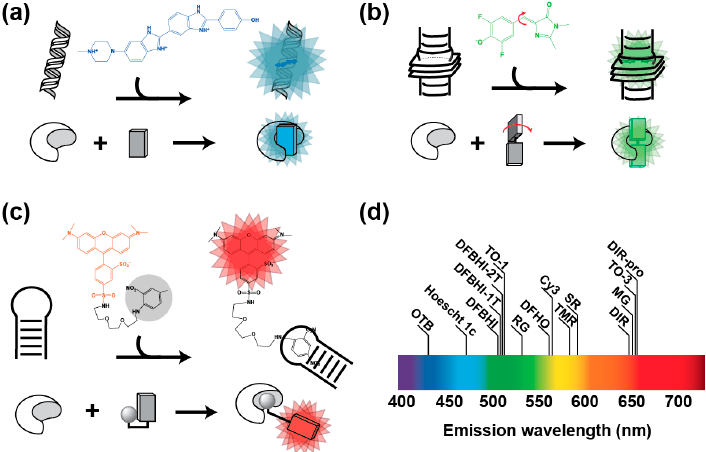
Figure 1. Main conception strategies of fluorogens. ( a ) Environment sensitive fluorogens. Molecules such as Hoescht 33258 (formula in blue) emit blue fluorescence upon association with DNA minor groove. Modifying the fluorogen with bulky groups allows aborting this non-specific DNA binding capacity, while preserving the fluorogenic capacity that can be now specifically activated by the cognate aptamer [35]. ( b ) Molecular rotor fluorogens. DFHBI (formula in green) [29] eliminates excitation energy by molecular movements (red arrows). However, upon association to the cognate aptamer, movements are restricted and fluorogen energy is eliminated by fluorescence emission. ( c ) Quenched fluorogens. Sulforhodamine B (formula in red) fluorescence is quenched by a conjugated dinitroaniline (formula in black and shaded in gray) [32]. However, the fluorescence is restored upon the specific recognition of the quencher (or the fluorophore moiety in other systems) by an aptamer. In every example, RNA aptamer is represented by the croissant-shaped object and the fluorogen by the rectangles. ( d ) Distribution of fluorogen emission wavelength along the visible spectrum. Fluorogenicity can also result from intramolecular movements allowing for non-radiative relaxation of the dye upon excitation (Figure 1b). Such compounds, hereafter called molecular rotors, are poorly fluorescent in their unbound form in a fluid environment. However, fluorescence can be restored by restricting intramolecular movements either by strongly increasing medium viscosity, or upon specific interaction with a nucleic acid. Triphenylmethane dyes (e.g., Malachite Green (MG) and Patent Blue, Table 1) were the first class of compounds for which specific RNA light-up aptamers were identified [19,20]. Among them, MG shows an impressive ~2400-fold fluorescence enhancement